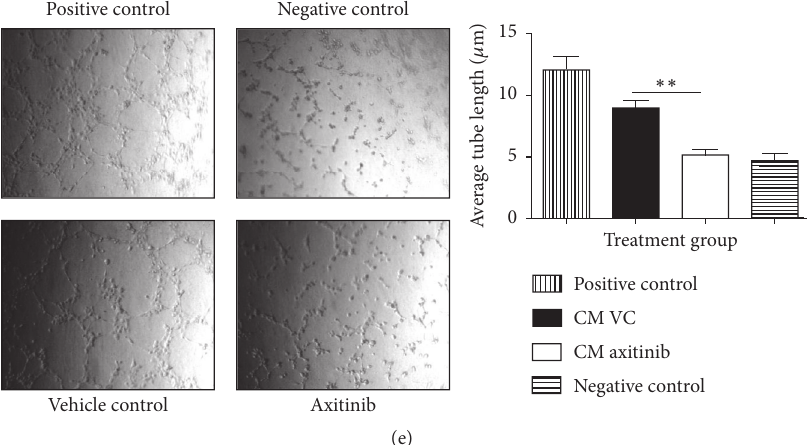
Figure 4: Characterization of axitinib. MLS 402 and MLS 1765 cells were treated with IC 50 axitinib (MLS 402, 1.2 𝜇 M; MLS 1765, 3.2 𝜇 M), imatinib (10 𝜇 M), or vehicle control for 2 h, lyzed, and analyzed for anolytes targeting the phosphorylation site of PDGFR 𝛼 , PDGFR 𝛽 , and c-Kit. The experiment was performed 3 times, and the data are presented as mean + SEM. t-AKT, total AKT (a). MLS 1765 cells were treated overnight with IC 50 axitinib or vehicle control and immunoprecipitated for total VEGFR3 (t-VEGFR3) and phospho-VEGFR3 (p-VEGFR3). Densitometry of total VEGFR3 expression and phospho-VEGFR3 expression following axitinib treatment (b). MLS 402 and MLS 1765 cells were treated with IC 50 axitinib or vehicle control for 2h, and then the cells were lyzed and analyzed for phospho-AKT and phospho-ERK1/2 by Bio-Plex. Three technical and biological replicates were tested. The data are presented as the mean + SEM (c). MLS 402 and MLS 1765 cells were treated overnight with IC 50 axitinib or vehicle control, and then cells were analyzed by RT-qPCR for the expression of VEGFR1, VEGFR3, VEGFA, and VEGFB. The experiment was performed three times, and the data are presented as the mean + SEM (d). HUVECs were suspended in Matrigel and then were treated with conditioned medium from cells that had been pretreated with IC 50 axitinib or vehicle control. Images were acquired at hourly intervals, and the figure displays representative images taken at 8h. Tube lengths were measured using ImageJ (version 1.47d). The experiment was performed three times, and the data are presented as the mean + SEM (right) (e). Ax, axitinib; CM, conditioned medium; IB, immunoblotting; Im, imatinib; IP, immunoprecipitation; VC, vehicle control; LO, Lipofectamine-only treated cells; Ut, untreated MLS cells. A paired, two-tailed 𝑡 -test was performed. ∗ 𝑝 < 0.05 ; ∗∗ 𝑝 < 0.01 ; ∗∗∗ 𝑝 < 0.001 ; ∗∗∗∗ 𝑝 < 0.0001